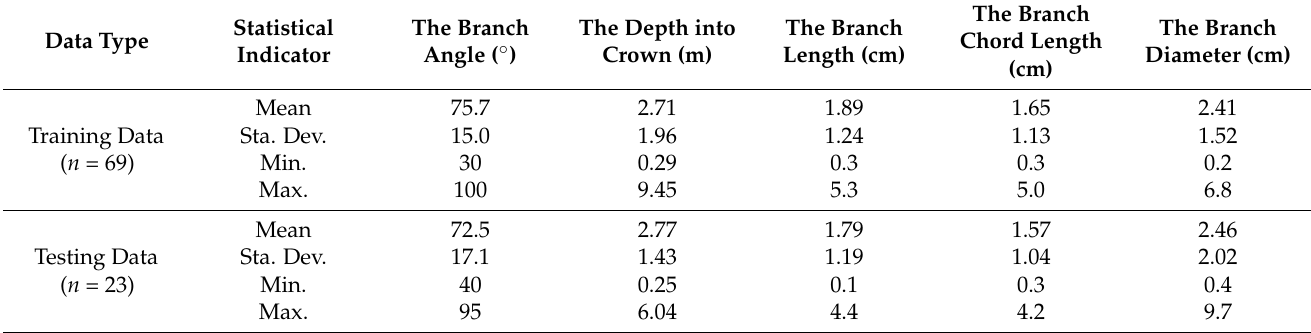
Table 2. The basic information on the branches of Simao pine with the longest